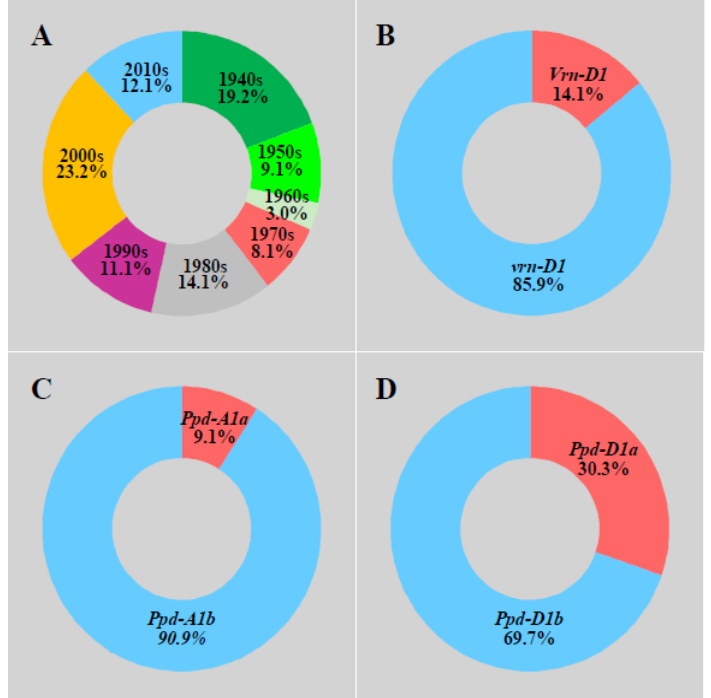
Figure 1. Eras and allele distribution of wheat varieties. Note that the 1940s represent the varieties dating during and prior to the 1940s. ( A ) 100 wheat varieties were divided into eight groups according to their eras of release. ( B ) 100 wheat varieties were divided into the vrn-D1 allele. ( C ) 100 wheat varieties were divided into the Ppd-A1 allele. ( D ) 100 wheat varieties were divided into the Ppd-D1 allele.